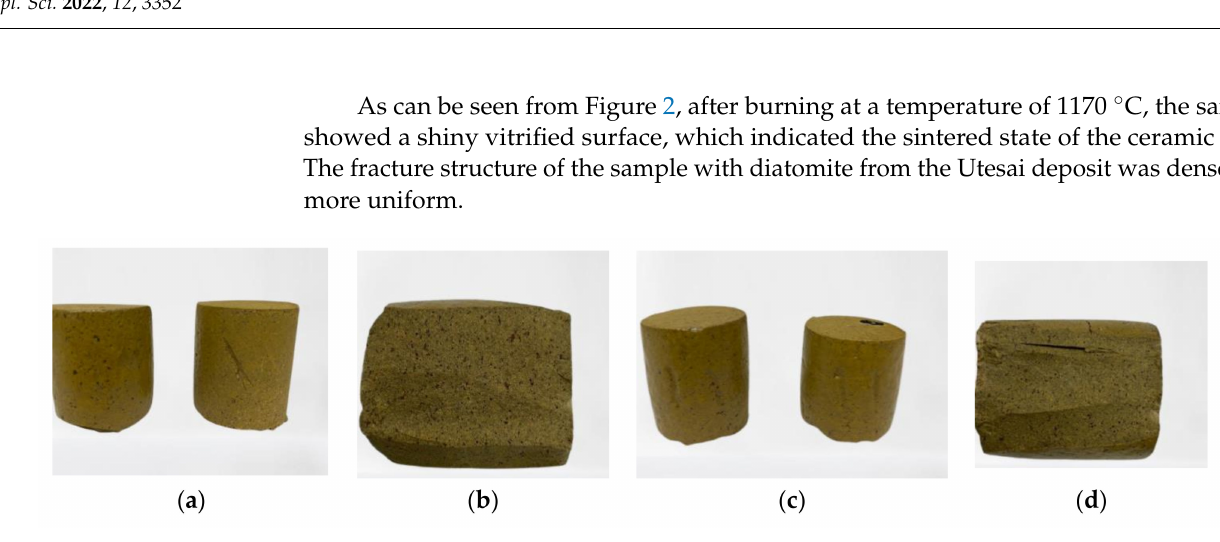
Figure 2. The samples with diatomite after burning at a temperature of 1170 ◦ C: ( a ) samples with the addition of diatomite from the Zhalpak deposit. ( b ) Sample structure after the compression test. ( c ) Samples with the addition of diatomite from the Utesai deposit. ( d ) Structure of the sample after the compression test.